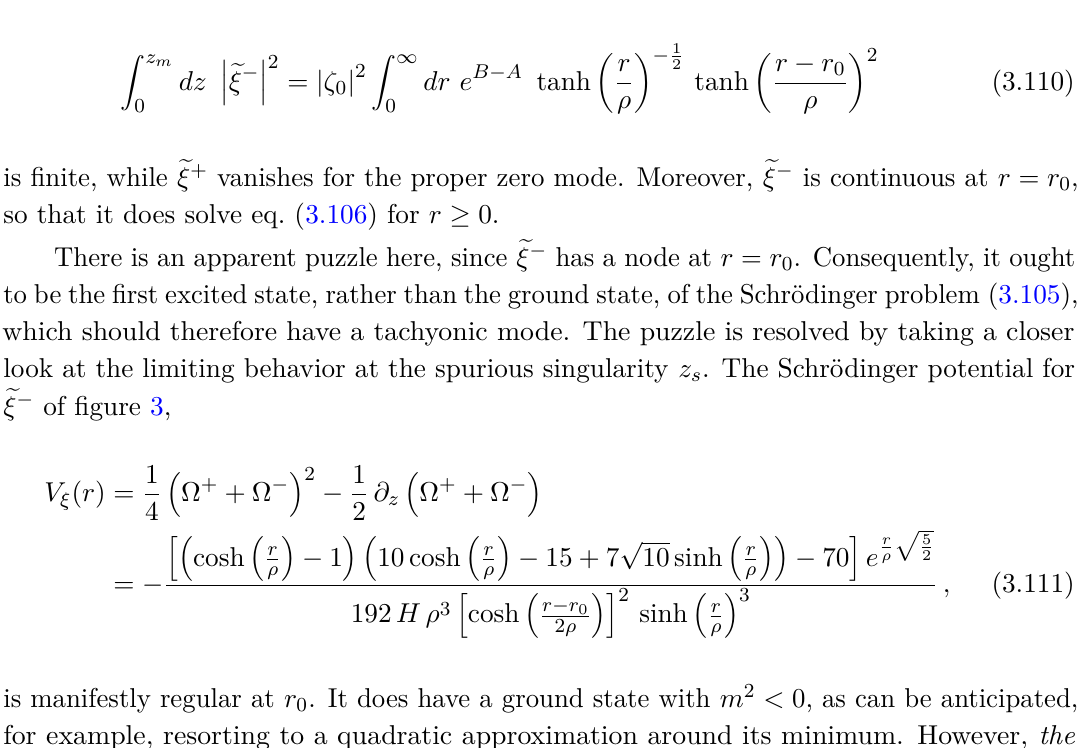
Figure 3 . The potential V ξ of eq. (3.111), in units of 1 in eq. (3.14). The plots are displayed up to the right end of the interval, z ’ 2 . 24 z